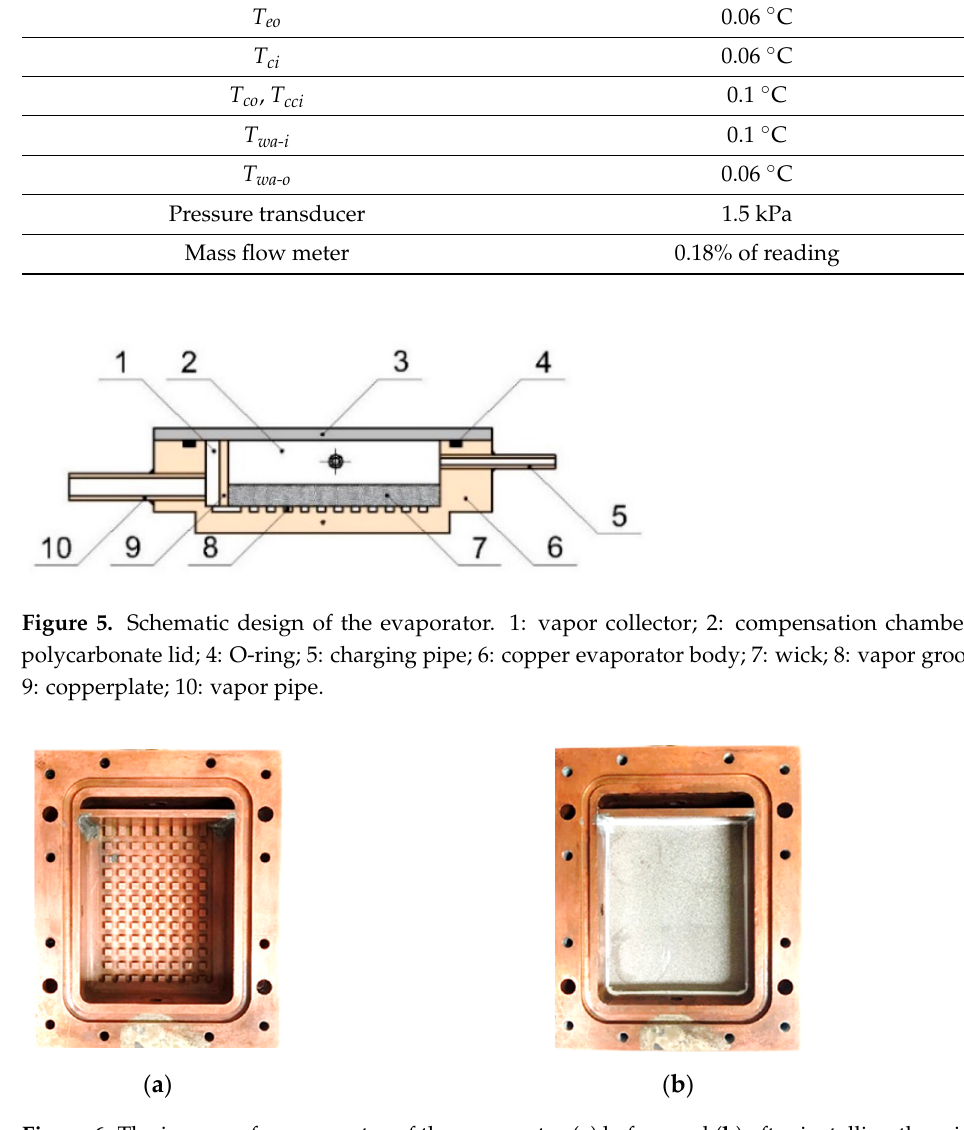
Figure 6. The inner surface geometry of the evaporator ( a ) before and ( b ) after installing the wick. Table 4. Uncertainty values.